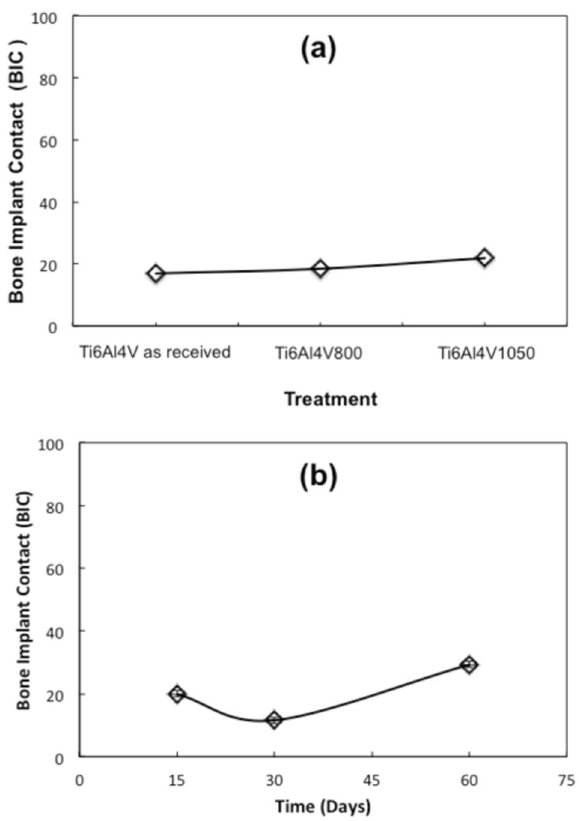
Fig. 5 Bone Implant Contact (BIC) for a Ti6Al4V as received, Ti6Al4V 800 , and Ti6Al4V 1050 after 60 days of implanted time and b for each study